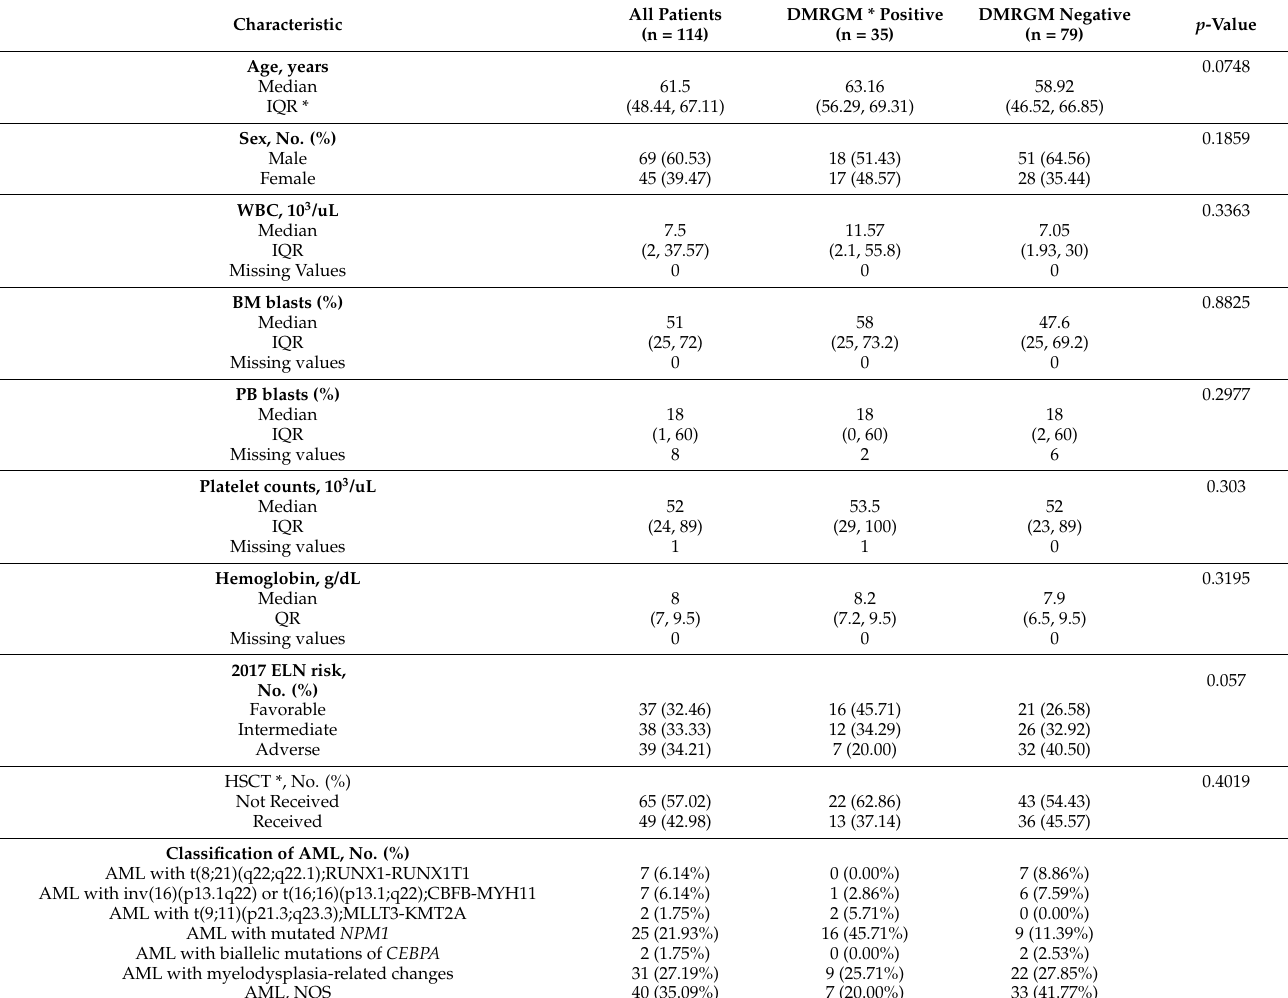
Table 1. Clinical/laboratory characteristics and AML classification of patients according to DNA methylation regulatory gene mutation status.